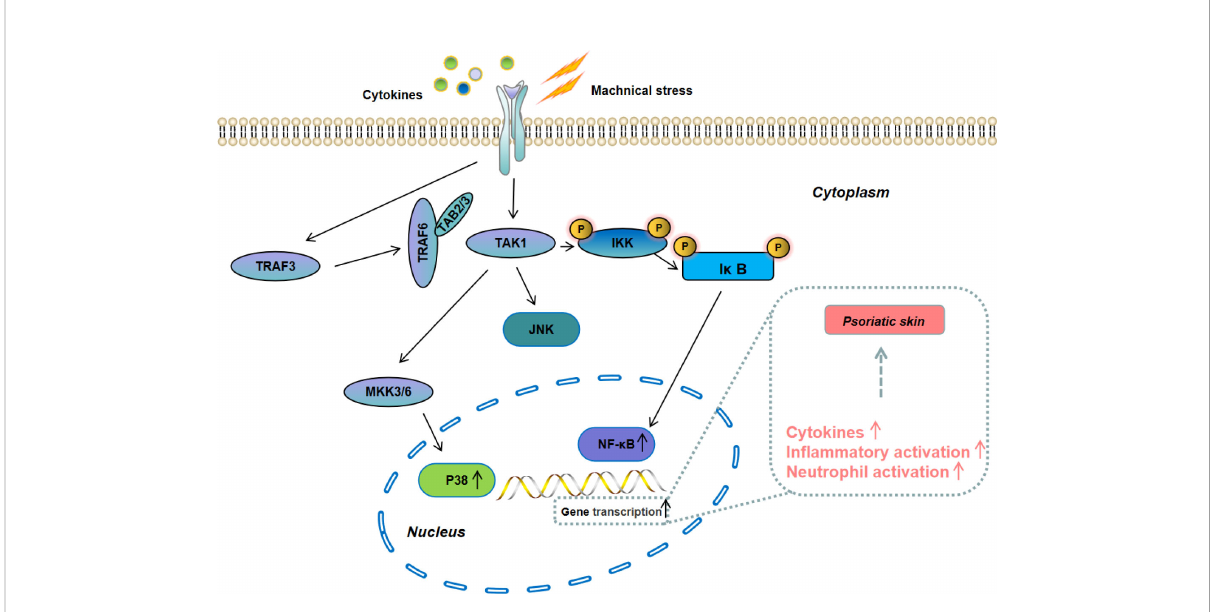
FIGURE 4 Schematic illustration of the MAPK/NF- k B signaling